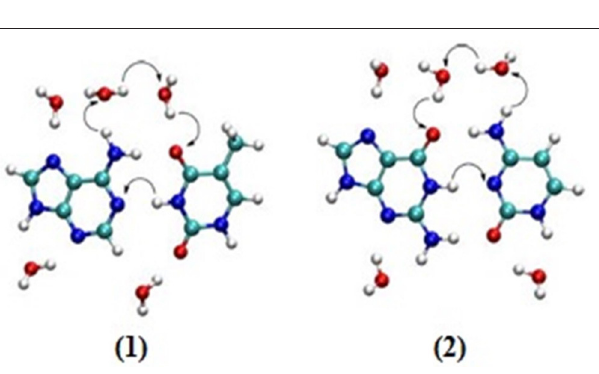
FIGURE 7 | Suggested mechanisms (by arrows) for double proton transfer in hydrated (1) AT and (2) GC base pairs.